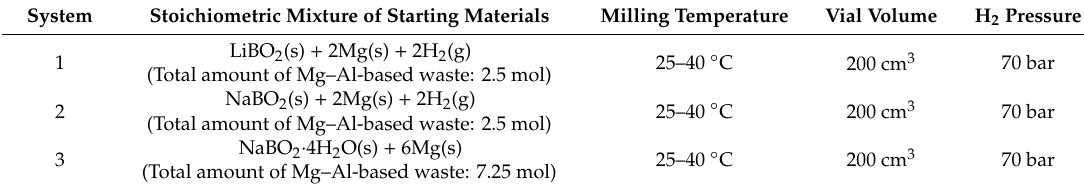
Table 2. Stoichiometric compositions with respect to the amount of Mg in Mg–Al-based waste of starting materials, milling atmosphere, and proposed